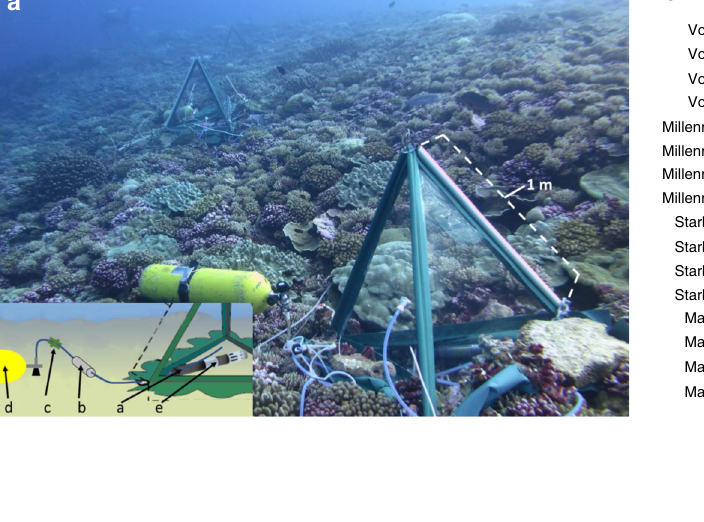
differed signi fi cantly by Island across all samples and within both day and nighttime subsets of the data (PERMANOVA p < 0.001),